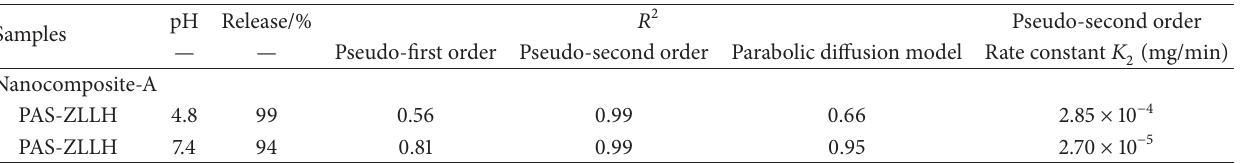
Table 3: Rate constant ( 𝑘 ) and correlation coefficient 𝑅 2 determined from the release kinetics of PAS from PAS-ZLH (nanocomposite-A) into PBS solutions of pH 7.4 and pH 4.8.